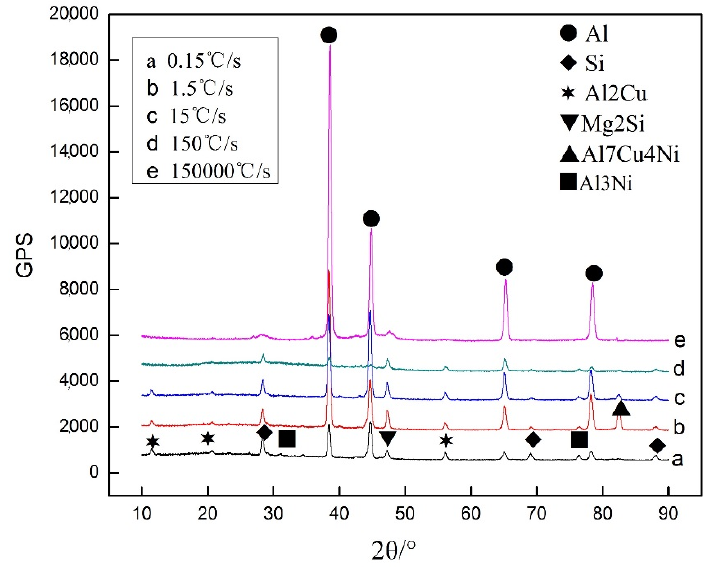
Figure 3. XRD analysis in the Al-13Si-4Cu-1Mg-2Ni alloy solidified with different cooling rates. ( a ) 0.15 °C/s; ( b ) 1.5 °C/s; ( c ) 15 °C/s; ( d ) 150 °C/s; ( e ) 1.5 × 10 5 °C/s.